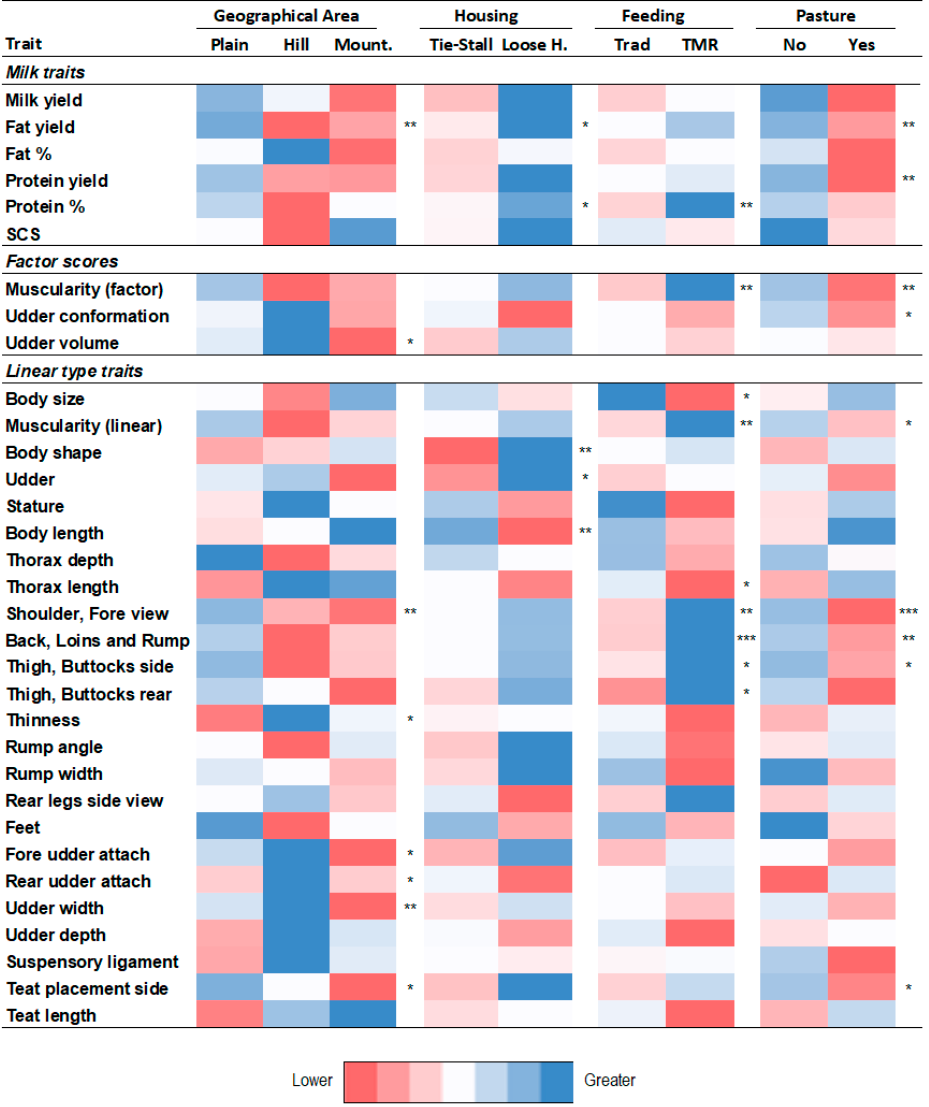
Figure 4. Least square means of ZGZ’ variance in different levels of the environmental categories (Geographical area; Housing; Feeding; occurrence of Pasture) considered in the study. Values of variance are shown as gradient of colors (red = lower values; blue=higher values). The gradient has to be seen within trait (that is, line by line). The significance of differences among the levels of the same environmental category was tested via GLM analysis. Mount = Mountain; Loose H. = Loose Housing; TMR = Total Mixed Ration; Yes = Occurrence of pasture: yes; No = Occurrence of pasture: no; * = p ≤ 0.005; ** = p ≤ 0.01: *** = p ≤ 0.001.